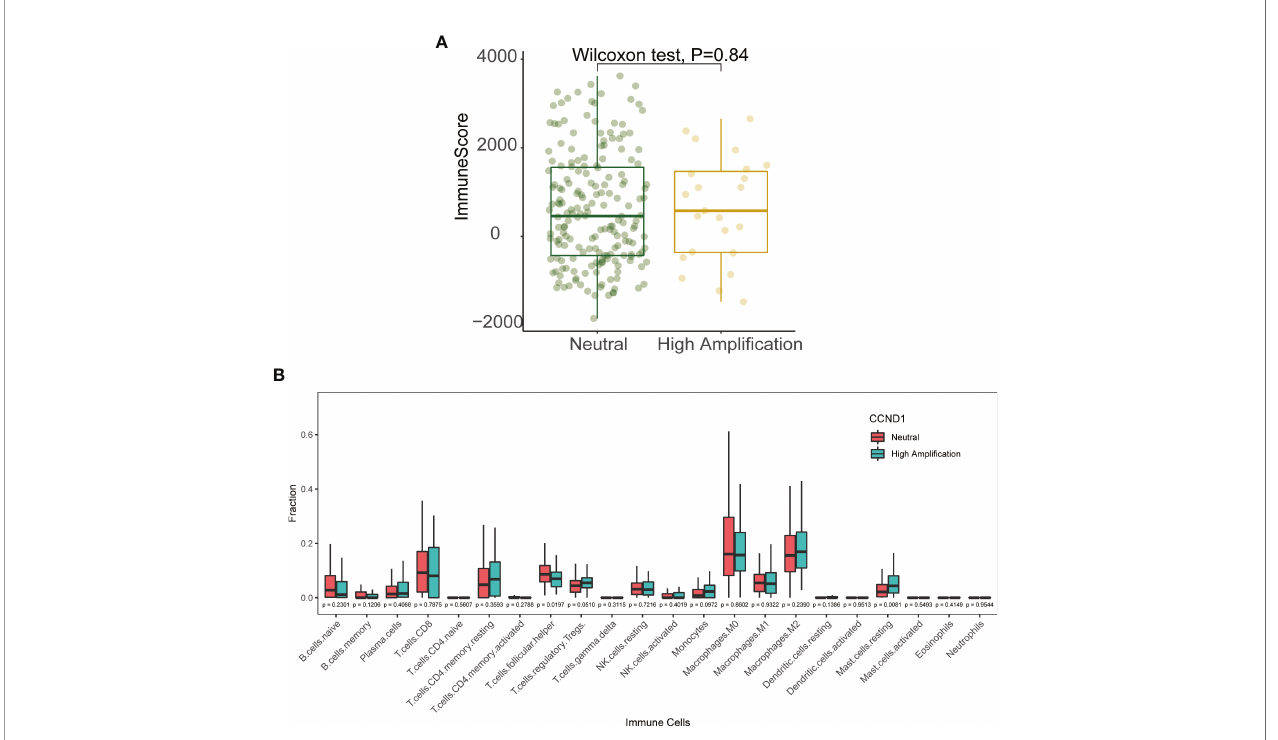
FIGURE 4 | Immune landscape of the CCND1 ampli fi cation in samples from patients with melanoma in the TCGA database. (A) The relationship between CCND1 ampli fi cation status and in fi ltrating fraction of stromal and immune cells using ESTIMATE on data from the TCGA database ( n =237). (B) The relationship between CCND1 ampli fi cation status and immune in fi ltration of 22 immune cell subsets using CIBERSORT on data from the TCGA database ( n =237). MSKCC, the Memorial Sloan Kettering Cancer Center; TCGA, The Cancer Genome